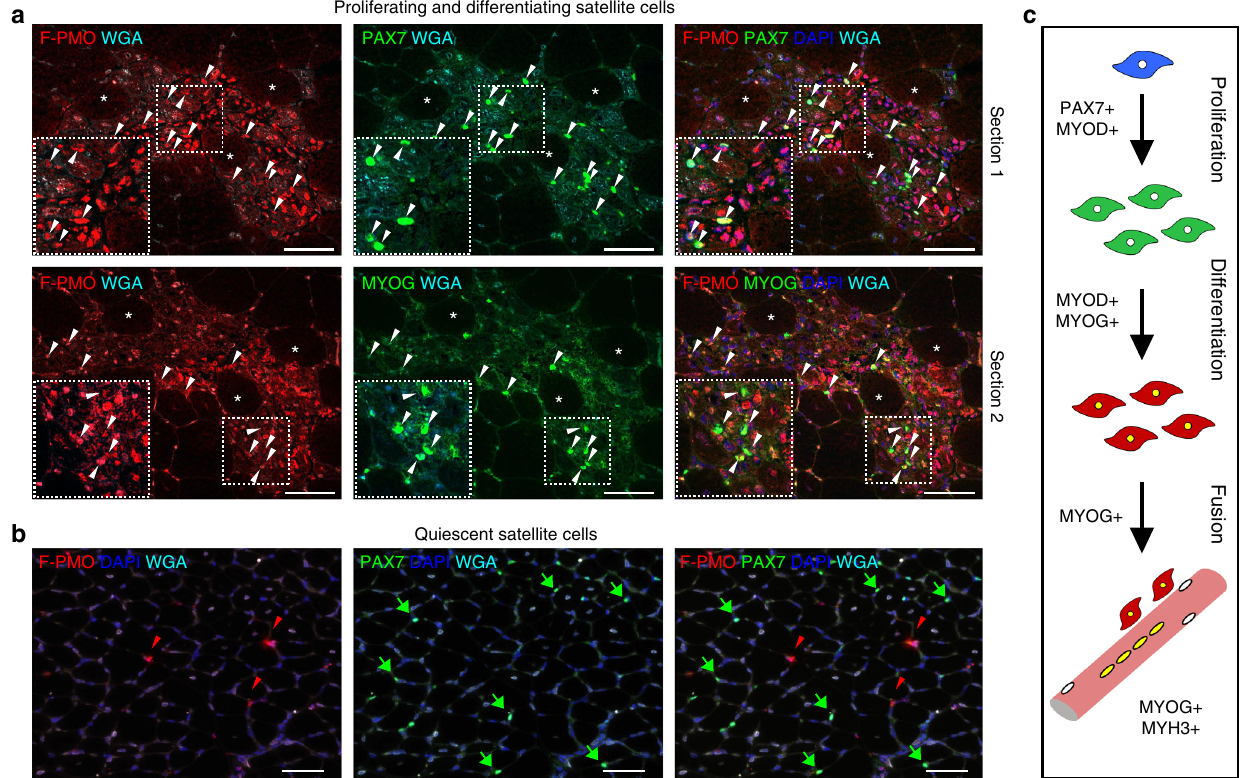
Fig. 7 PMO in fi ltration of proliferating and differentiating myoblasts facilitates entry into actively regenerating fi bers. a PMO uptake in proliferating (PAX7 +ve , top panel ) or differentiating (MYOG +ve , bottom panel ) myoblasts within regenerating foci. mdx mice treated at 4 weeks with a single dose of F-PMO (400mg/kg, n = 3) and euthanized 24h after PMO delivery. Asterisks denote fi ber identity between serial cross-sections; arrowheads denote PAX7 +ve or MYOG +ve ( green ) cells co-labeled for PMO ( red ). Myoblasts void of PMO remain unmarked for comparison. Images acquired by confocal; dashed boxes show magni fi ed inlay and scale bars represent 50 μ m. b PAX7 +ve satellite cells residing in non-regenerating muscle regions do not co-localize with PMO +ve nuclei. Arrowheads mark PMO +ve nuclei. Merged image shows PMO ( red ), PAX7 or MYOG ( green ), WGA ( cyan ), and DAPI ( blue ). Gastrocnemius shown; scale bars represent 50 μ m. c Schematic representation of myoblast proliferation, differentiation, and fusion with corresponding gene